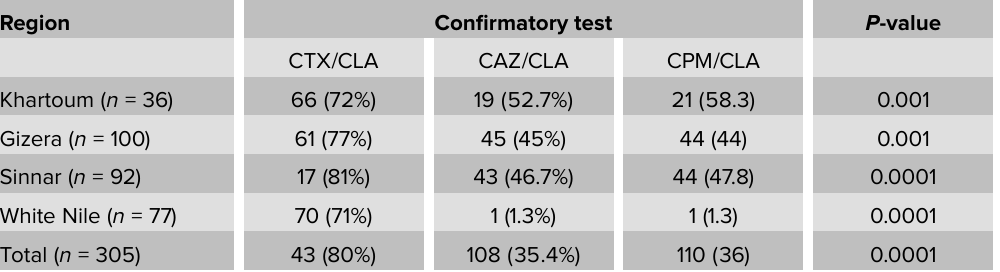
TABLE 3: Phenotypic confirmatory test of ESBLs-producing isolates in different regions of Sudan.